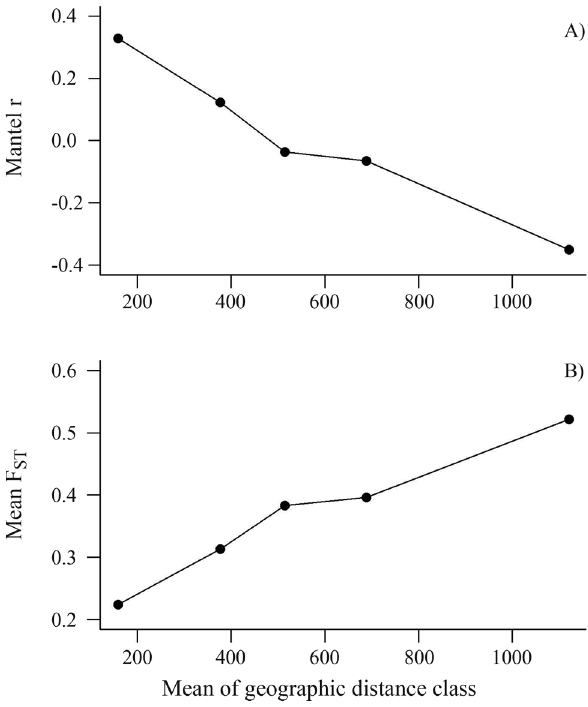
Figure 3 - Mantel correlogram (A) and distogram (B), the latter one given by the mean F ST in each distance